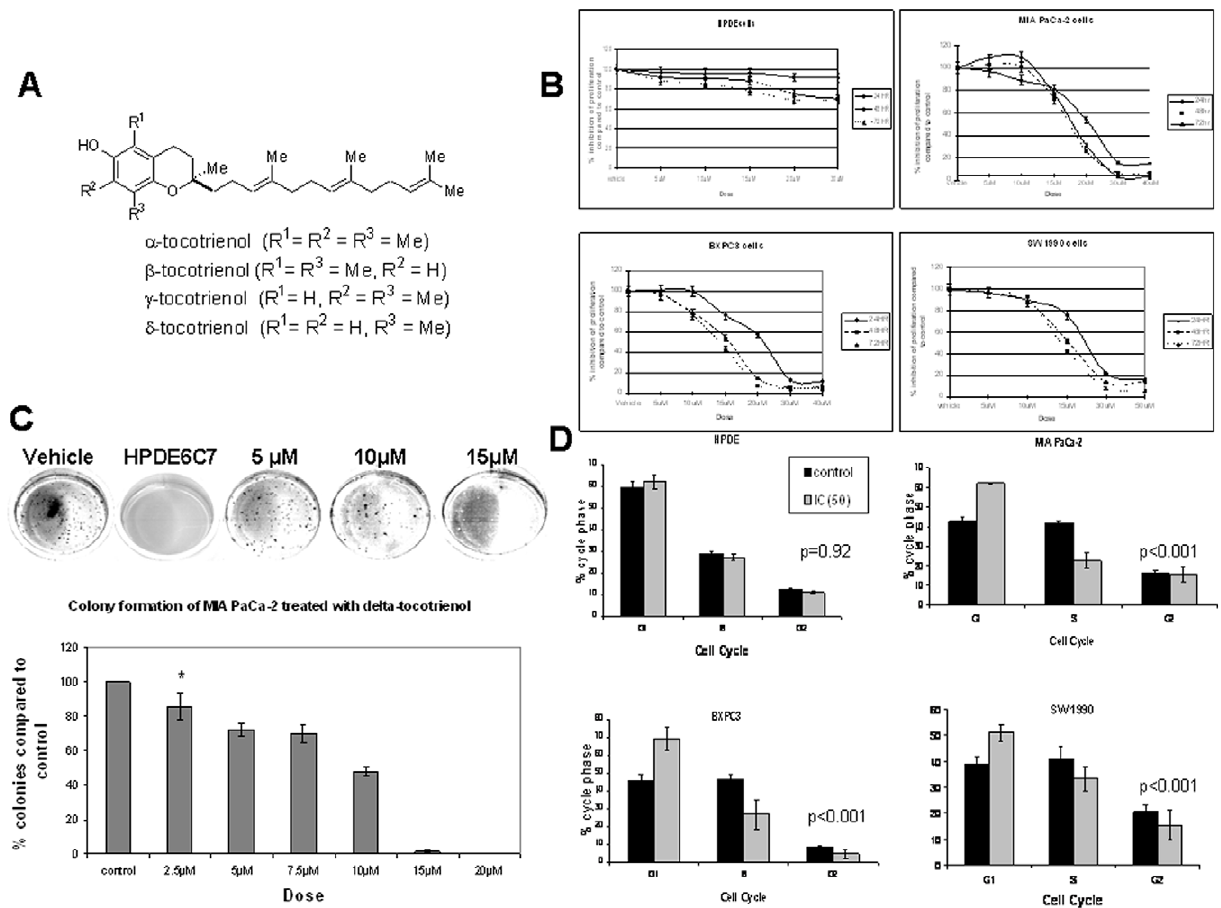
Figure 1. d -Tocotrienol inhibits pancreatic cancer growth. A , Chemical structures of tocotrienols. B , d -tocotrienol selectively inhibits pancreatic cancer cell proliferation. HPDE6 C7 and human pancreatic cancer cell lines MIAPaCa2, BXPC3, and SW1990 were treated with increasing concentrations of d -tocotrienol or vehicle and analyzed by MTT at 24, 48, and 72 hours. Results demonstrate selective inhibition of pancreatic cancer cells in a time- and dose-dependent manner. C , d -tocotrienol inhibits anchorage-independent growth of transformed MIAPaCa-2 pancreatic cancer cells. Number of colonies was normalized and compared to vehicle. *Concentration at which statistical significance begins. D , effects of d -tocotrienol on cell cycle progression. Pancreatic cancer cells and HPDE6 C7 cells were incubated in the presence of d -tocotrienol (IC 50 ) (gray) or vehicle (black) as control for 24 hours. Cells were collected for determination of cell cycle distribution by FACS analysis after cell staining with propidium iodide. Each analysis represents means 6 SD of 3 independent experiments. d -Tocotrienol inhibits G 1 -to-S cell cycle progression selectively in transformed pancreatic cancer cell lines.